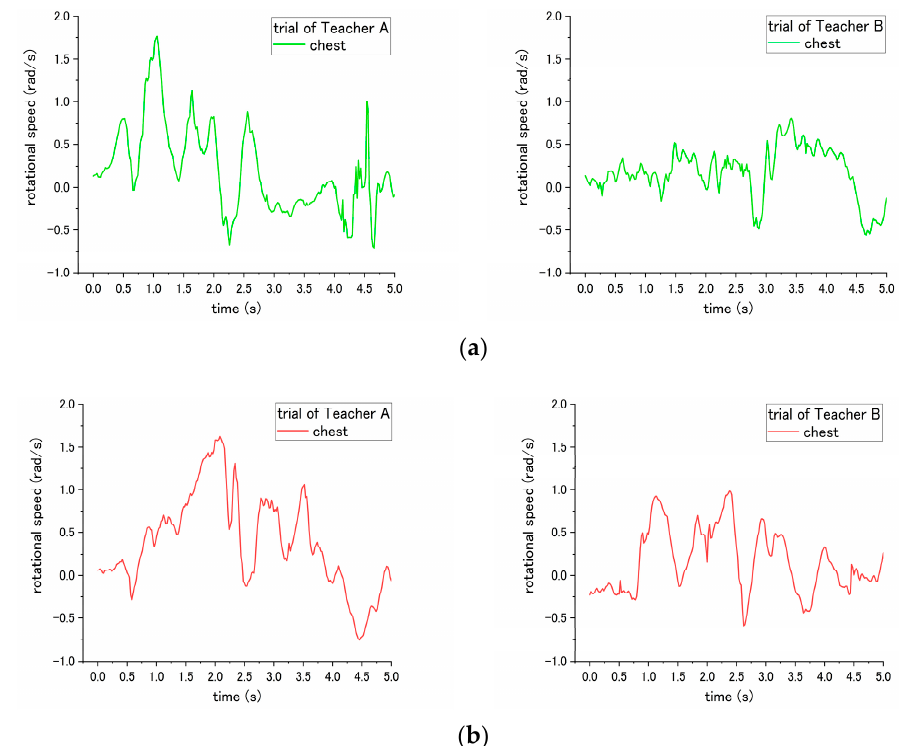
Figure 12. Rotational speed of patient’s chest during step No. 12 when the ( a ) correct way and ( b ) incorrect way were conducted at step No. 7.